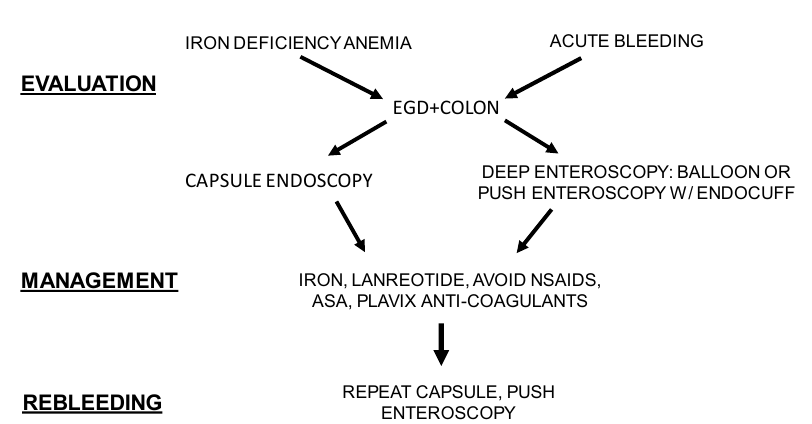
Figure 1. A schematic representation of GIADs management algorithm.